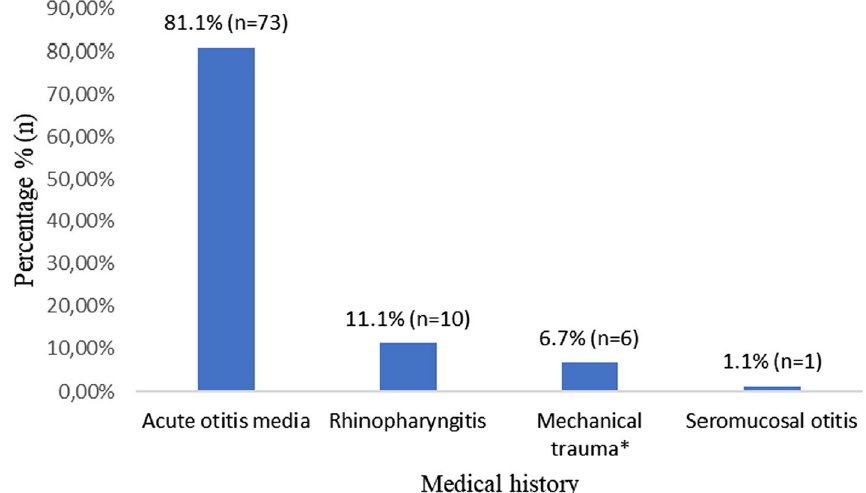
Fig. 1 Distribution of cases according to patients’ medical history. Mechanical trauma*- Ear trauma by cotton swab ( n slap trauma ( n